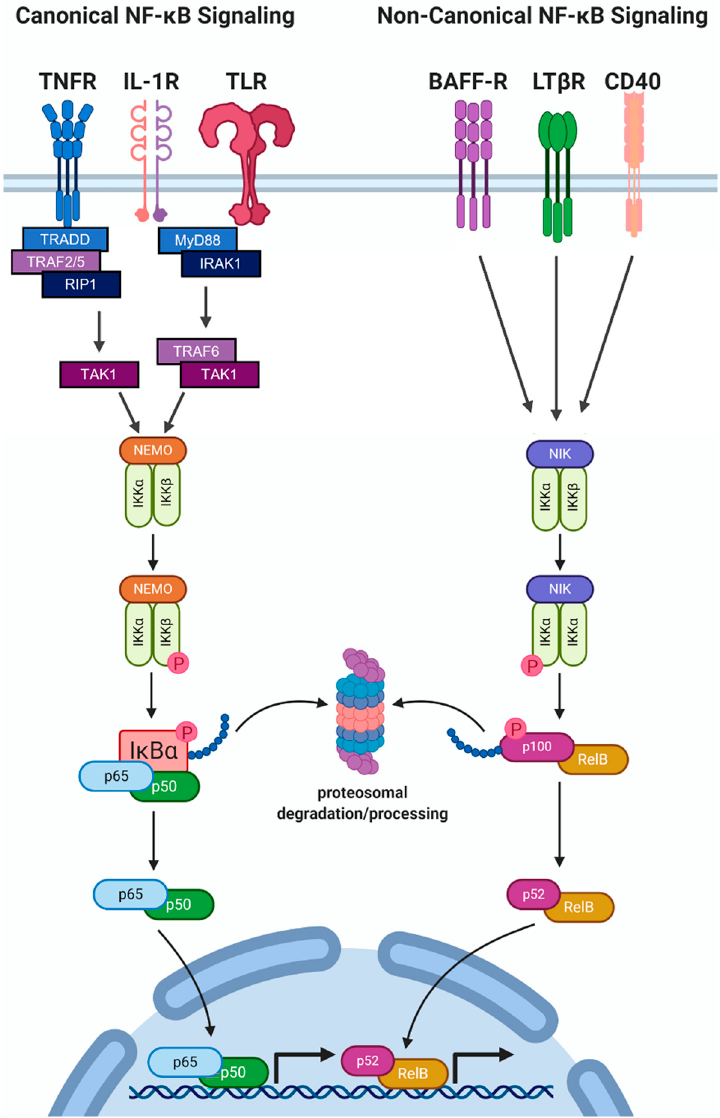
Figure 1. NF- κ B signaling. Canonical IL-1 signaling is induced by molecules such as IL-1, TNF, or LPS binding to their respective receptors IL-1R (Interleukin-1 Receptor), TNFR (Tumor Necrosis Factor Receptor), or TLR (Toll-like Receptor). Ligand–receptor interaction recruits Myeloid Differentiation Primary Response 88 (MyD88) adaptor protein and IL-1 Receptor-Associated Kinase 1 (IRAK1) to the IL-1R or TLR receptors, leading to TNF Receptor-Associated Factor 6 (TRAF6)/TGF β -Activated Kinase (TAK1)/I κ B Kinase (IKK; IKK α /IKK β /NEMO complex) activation and subsequent degradative phosphorylation of the Nuclear Factor Kappa B (NF- κ B) inhibitor, I κ B α . Cytoplasmic NF- κ B (p65/p50) is then freed from I κ B α binding to translocate to the nucleus to activate transcription. TNF receptor-associated death domain (TRADD), receptor-interacting protein kinase 1 (RIP1), and TRAF2 or TRAF5 (TRAF2/5) are recruited to TNFR to activate TAK1/IKK, leading to I κ B α degradation and NF- κ B nuclear translocation. In non-canonical NF- κ B signaling, molecules such as BAFF, CD40 ligand, or Lymphotoxin Beta bind to their respective receptors, B-cell Activating Factor Receptor (BAFF-R), Cluster of Differentiation 40 (CD40), or Lymphotoxin Beta Receptor (LT β R) to activate NF- κ B-inducing Kinase (NIK), which phosphorylates and activates IKK α . Activated IKK α phos- phorylates p100, leading to p100 ubiquitination and proteolytic cleavage into the p52 subunit. The RelB/p52 heterodimer is then able to translocate to the nucleus and activate gene transcription. Image created using